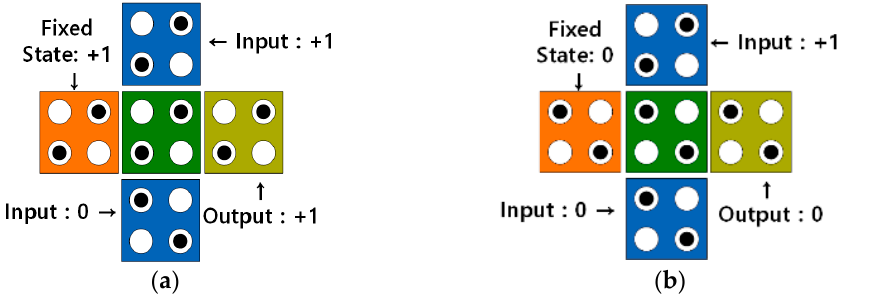
Figure 2. 3-input majority gate: ( a ) OR gate; ( b ) AND gate.